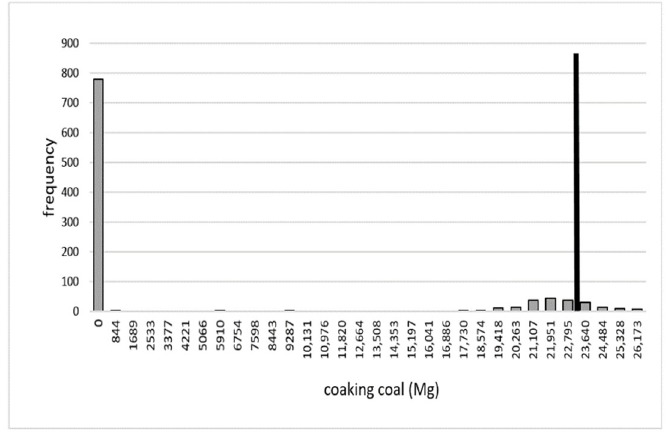
Figure A20. Histogram showing frequencies of achieving given quantity of sales of coking coal (“Export 1”) for mine “E” with σ yprog .